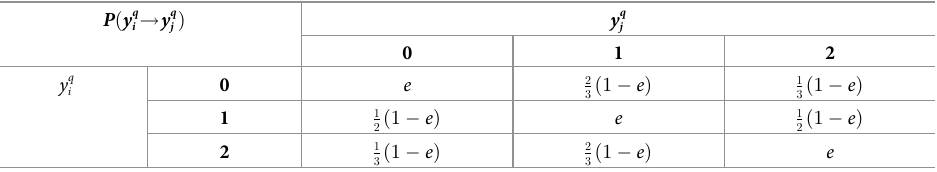
Label attack. In practice, the vagueness of query intent, insufficient domain knowledge, and ambiguous definition of relevance levels make it hard for human judges to assign proper relevance labels to some documents. Practically speaking, the probability of judgment errors in various relevance degrees is not equal. Even if human annotators misjudge a document, they are more probable to label it closer to its ground-truth label. Inspired by [48], we define the non-uniform error probabilities in Table 2 where entries of this table correspond to the proba- bility that a document with ground-truth label y q is prone to be labeled as y q . We randomly i j changed the labels of the training data using the probabilities in Table 2. Then, each model was trained on the noisy training data. Clean test data were used to evaluate each model. We con- ducted two sets of experiments, namely low label noise (i.e., e = 0.85) and high label noise (i.e., e = 0.7). Table 3 reports the performance of the algorithms on the clean test data. The values in these figures are the average of 5 folds. For the low noise scenario, the differences between the respectively. Notably, the gaps were even larger for the high noise scenario (AP@5 = 3.08%, the baseline models are susceptible and degrade more severely as more noise is added to the training set.